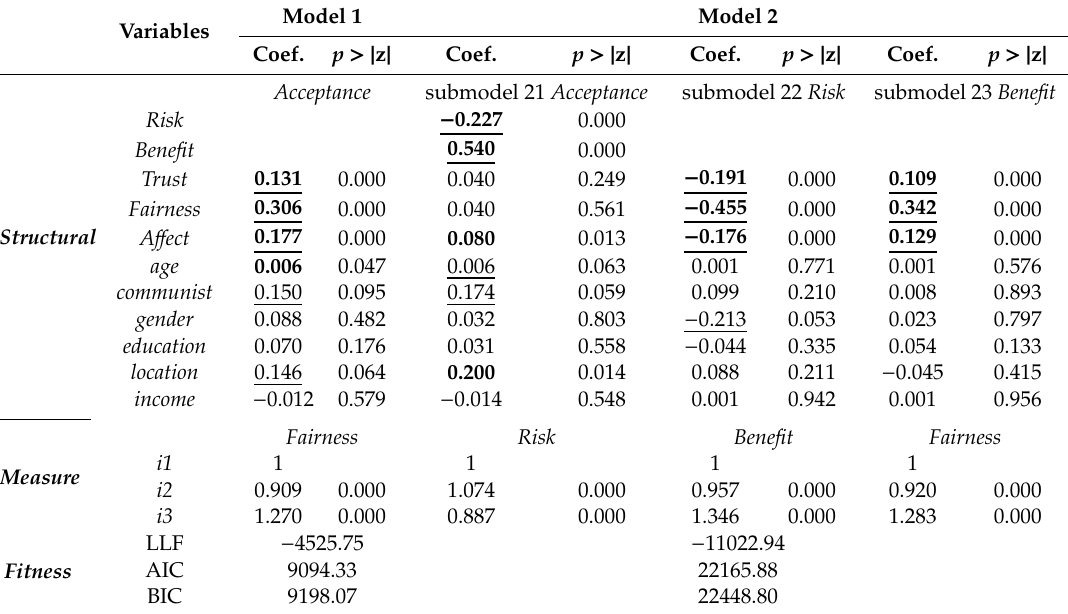
Table 2. Results of the generalized structural equation